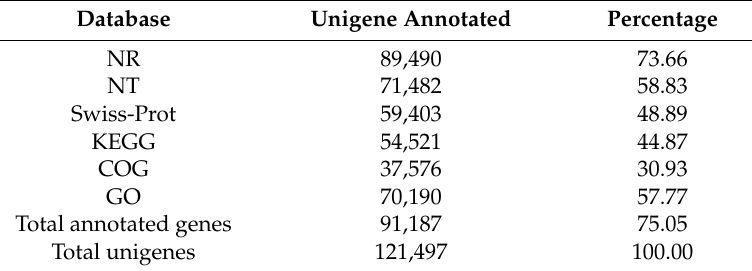
Table 3. Annotation of impatiens unigenes using the NT (the non-redundant nucleotide database), NR (the non-redundant protein database), SWISS-PROT, COG (Clusters of Orthologous Groups of proteins), KEGG (Kyoto Encyclopedia of Genes and Genomes) and GO (Gene Ontology Consortium) databases.